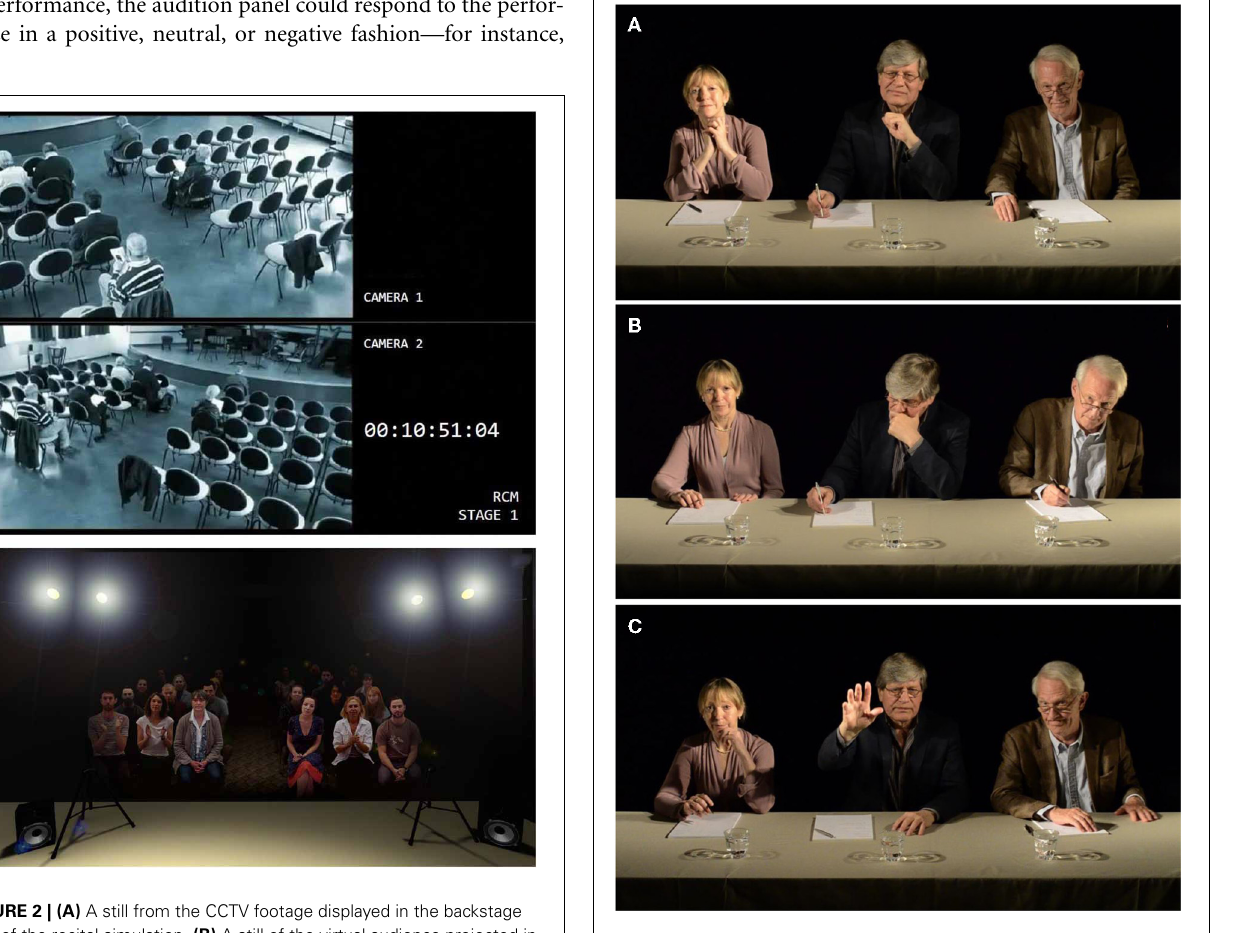
FIGURE 3 | Stills of the virtual audition panel (A) responding positively, (B) showing displeasure, and (C) stopping the